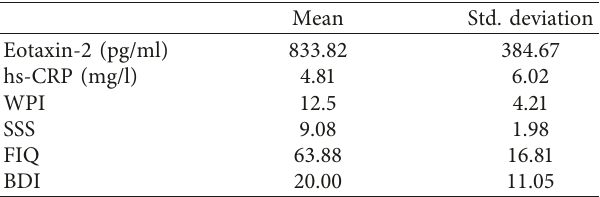
Table 1: Levels of the mediators and indices of disease activity in FMS cohort ( N � 50).